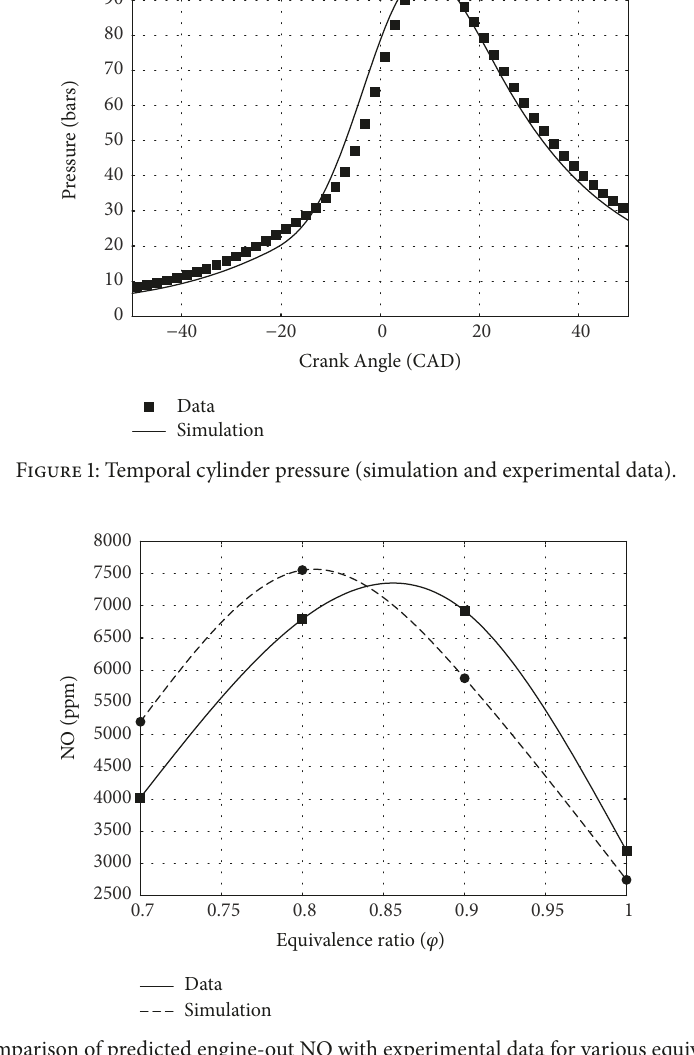
Figure 2: Comparison of predicted engine-out NO with experimental data for various equivalence